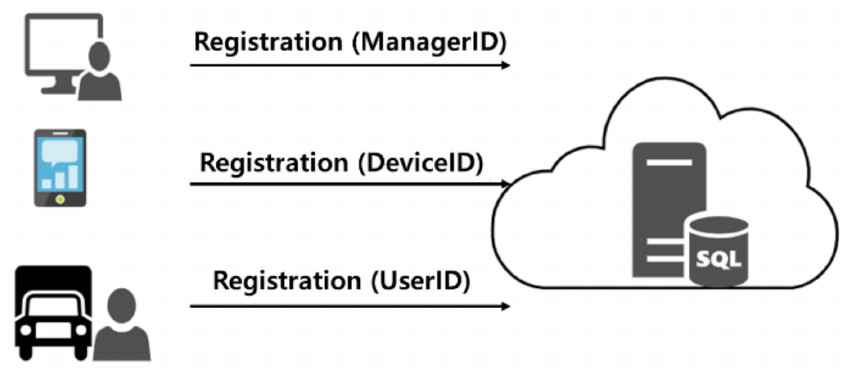
Figure 4. Registration process.